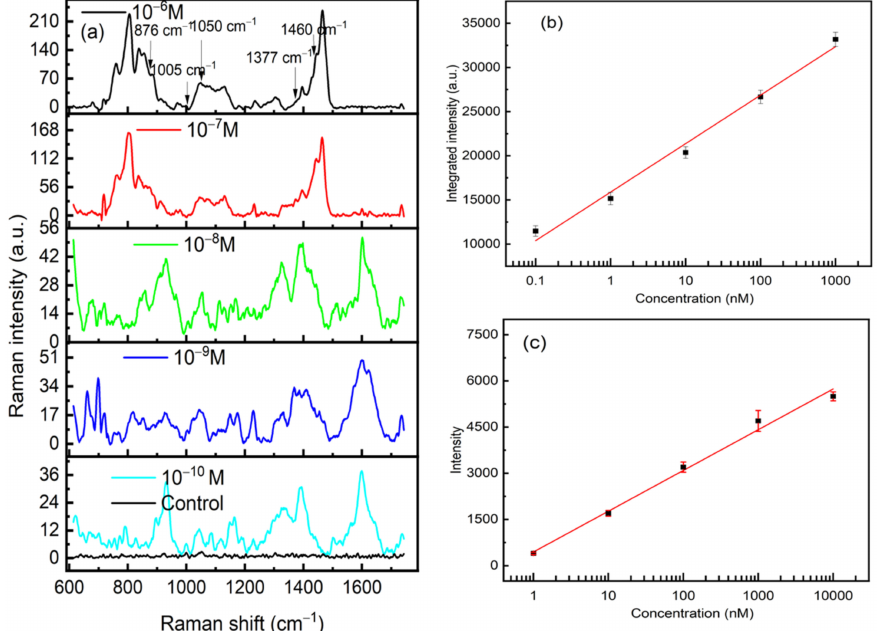
Figure 5. ( a ) Concentration-dependent SERS study of S protein by varying the concentration from 10 − 6 M to 10 − 10 M ( b ) A semi-log plot of the intensity as a function of the concentration of S protein. ( c ) A semi-log plot of the intensity as a function of the concentration of RBD protein. Acquisition time 3 s, Laser wavelength 632.8 nm. SERS spectra are recorded on the same substrate; each spectrum is the result of an average of three spectra taken from three different